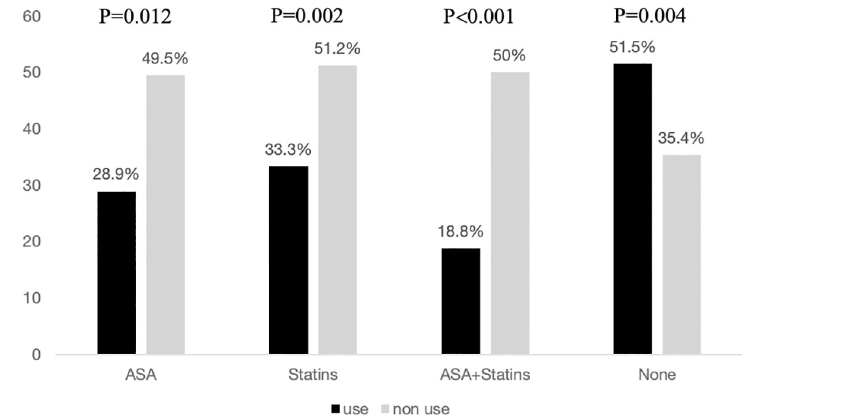
Fig 1. Percentages of IA rupture according to treatment at aneurysm diagnosis.